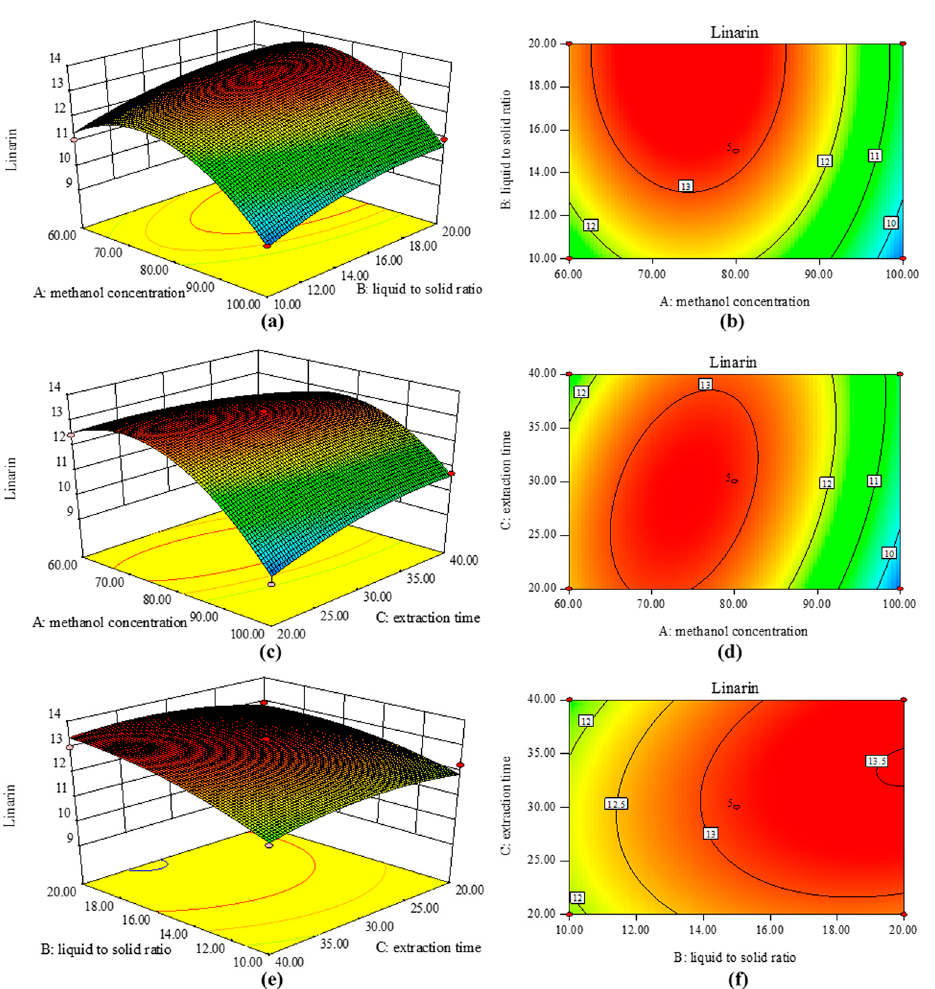
Figure 2. Response surface graphs of linarin: methanol concentration versus liquid/solid ratio ( a , b ); methanol concentration versus extraction time ( c , d ) and liquid/solid ratio versus extraction time ( e , f ). Initially, the yield of linarin increased with the methanol concentration, but it then declined sharply at higher concentrations, where the shape of the contour resembled a downward parabola.